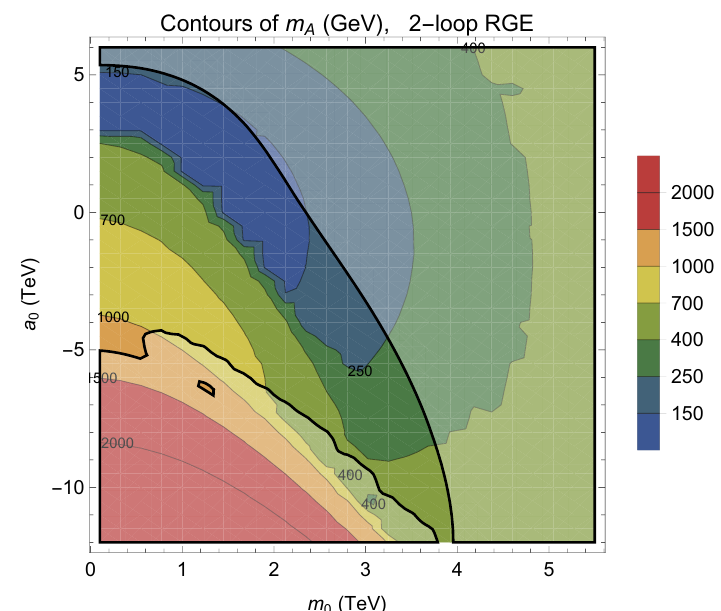
Figure 10 . A contour plot with values of the soft mass parameter M given a (cid:12)xed m 0 and a 0 . The fully-colored triangular region represents the one allowed by (cid:31) 2 < 9 and vacuum stability from (cid:12)gure 9.